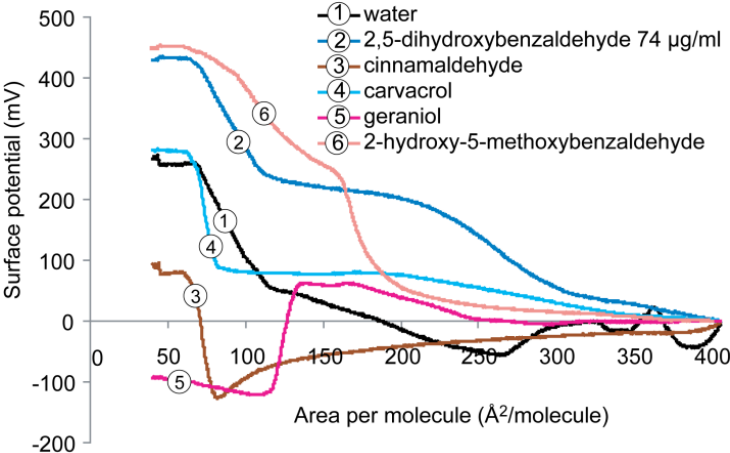
Figure 7. Surface potential versus molecular area isotherms recorded for the monolayers formed by cardiolipin on subphases containing water with and without